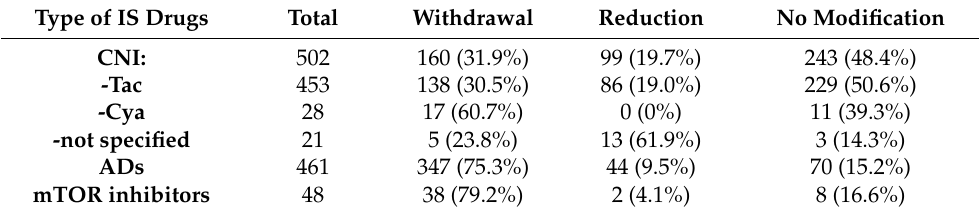
Table 3. Management of immunosuppressive drugs in kidney transplant recipients with coronavirus disease 2019